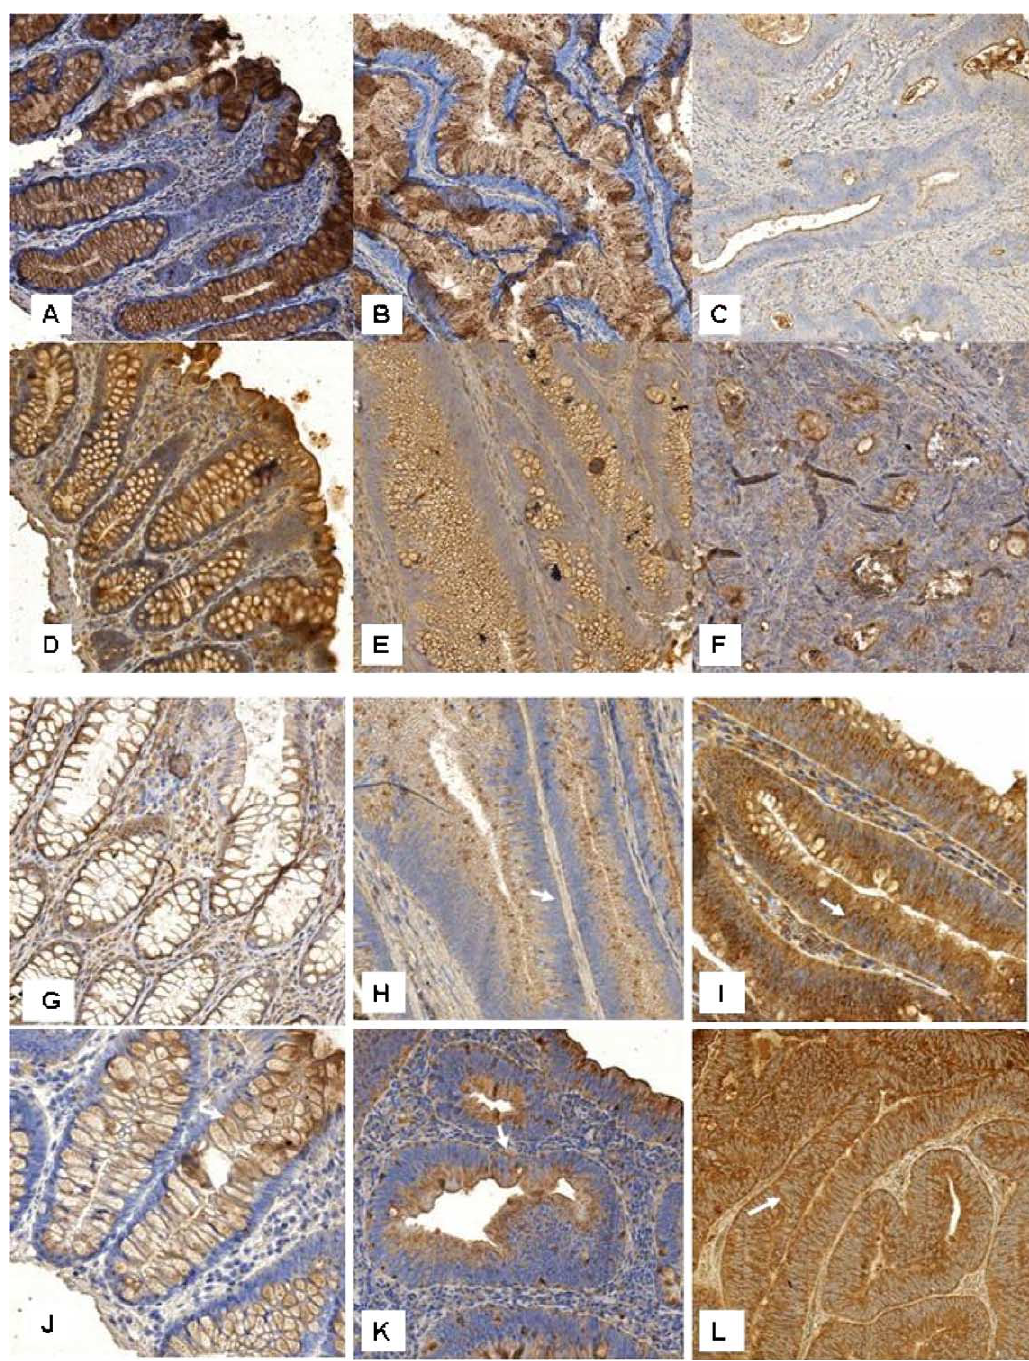
Fig. 2. Immunostaining for downregulated PTGDR and AMN, and upregulated osteopontin and osteonectin in TMA sections. Amnionless homolog/prostaglandin D2 receptor expression in normal colonic (A/D), dysplastic adenomatous (B/E) and CRC (C/F) samples. Osteopon- tin/osteonectin expression in normal colonic (G/J), dysplastic adenomatous (H/K) and CRC (I/L) samples. White arrows in figure G and J show apical cytoplasmatic staining in normal colonic epithelial cells. White arrows in figure H and K show moderate basal cytoplasmatic staining. Arrows in figure I and L show diffusely stained tumorous